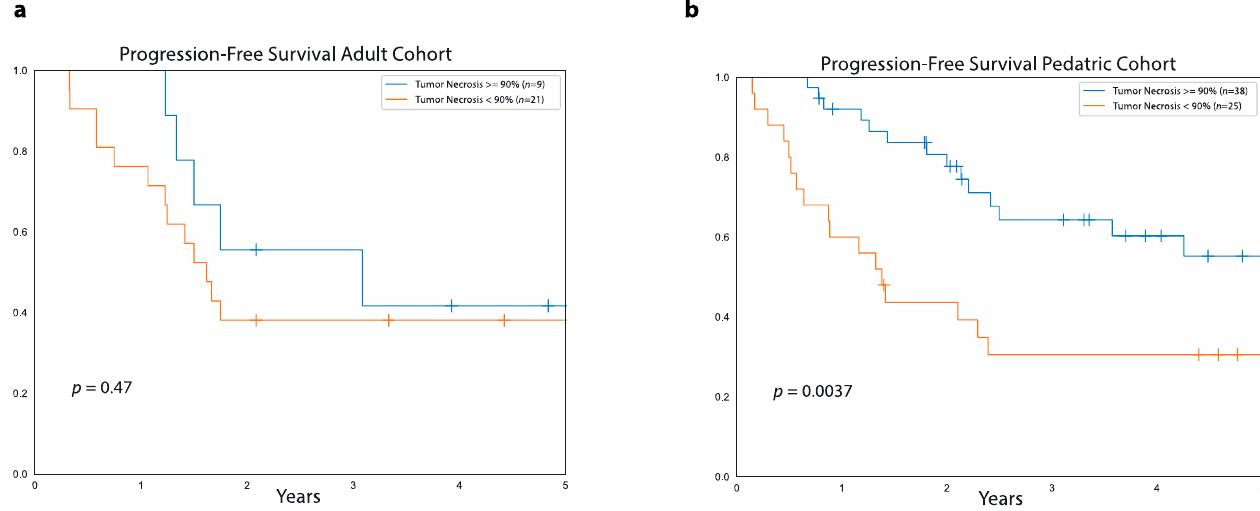
Figure 3. Relationship between PFS and tumor necrosis after neoadjuvant chemotherapy. Data show progression-free survival for patients with ≥ 90% tumor necrosis (blue curve) and < 90% necrosis (orange curve) after neoadjuvant chemotherapy in the adult cohort ( a ) and the pediatric cohort ( b ).